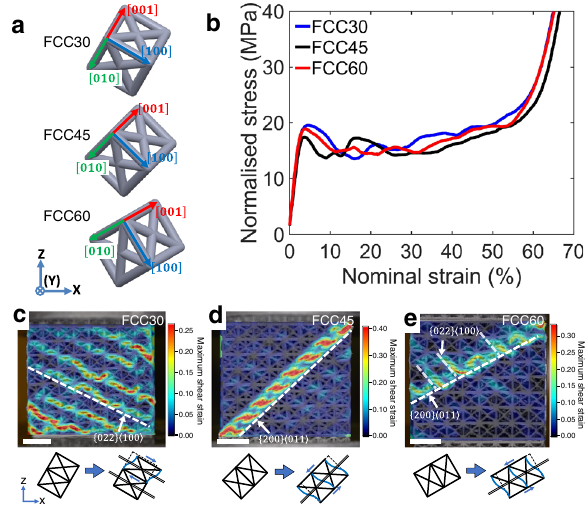
Fig. 1 Experiment results of singly orientated FCC-inspired meta-crystals. a The three lattice orientations of singly orientated meta-crystals: FCC30, FCC45 and FCC60, under a global orthogonal coordinate system, where the compressive loading direction is parallel to global Z axis. b Corresponded stress – strain curves, where stress was normalised by respective relative densities. c – e Localised deformation behaviour revealed by DIC analyses at a global nominal strain of 10% — cubic frame insets were used to show the lattice orientation and shearing direction. The length-scale bar in ( c – e ) is